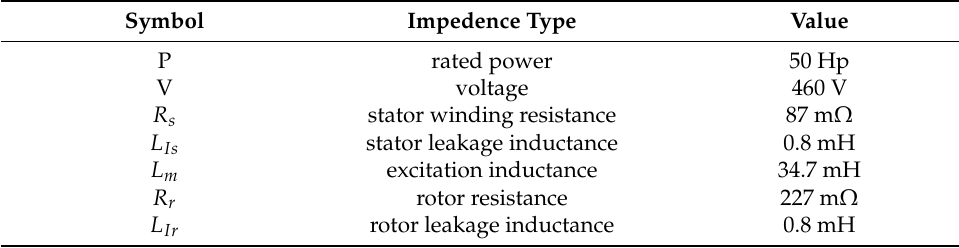
Table 1. Induction machine parameter